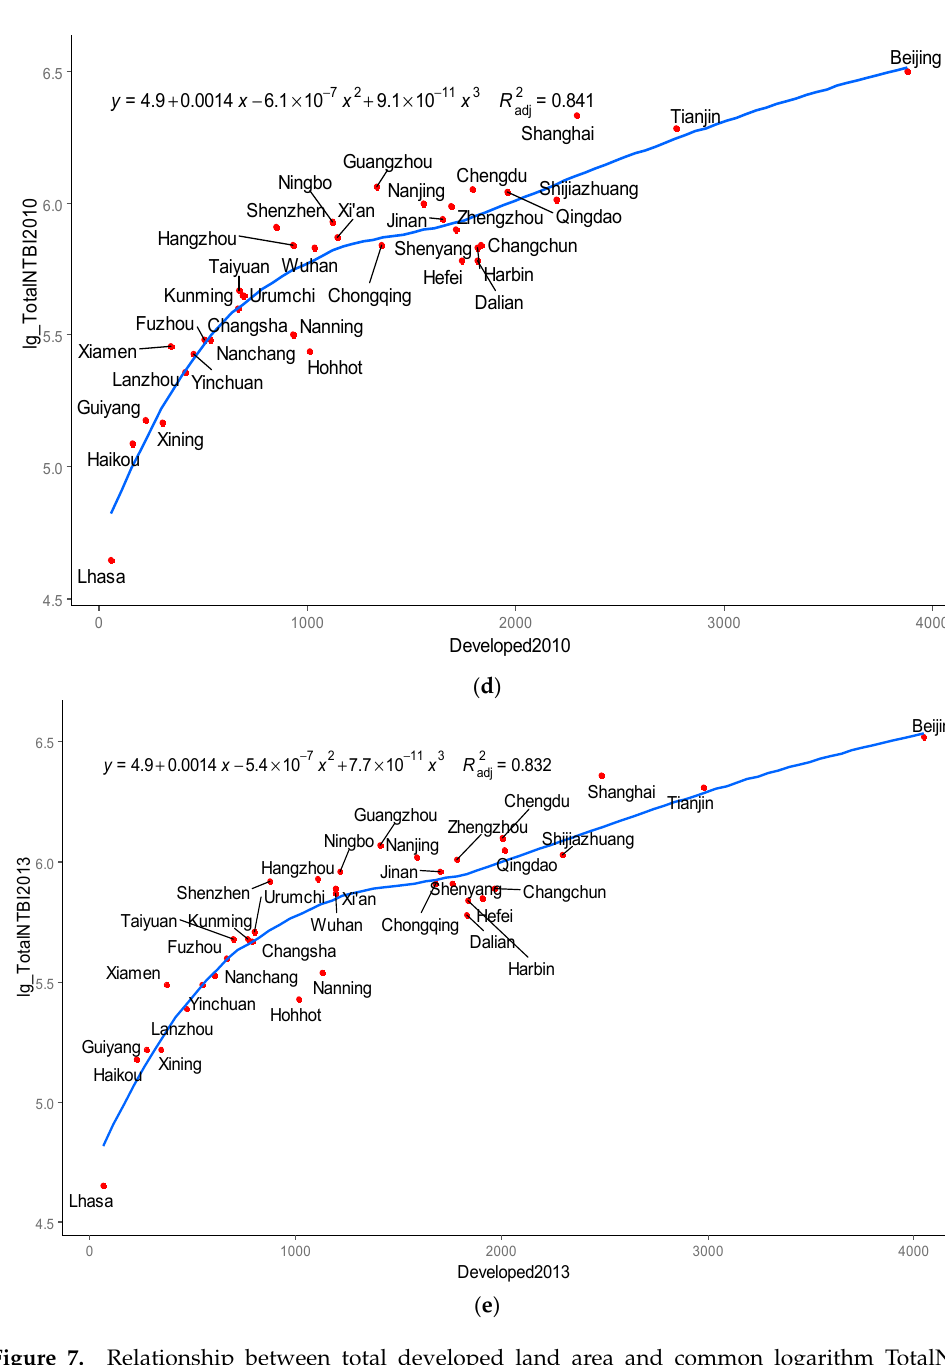
Figure 7. Relationship between total developed land area and common logarithm TotalNTBI (lg_TotalNTBI) in ( a ) 2000, ( b ) 2005, ( c ) 2008, ( d ) 2010, and ( e ) 2013. Total developed land area was in km 2 and lg_TotalNTBI was in cumulative unitless DN value (CUDV). The fitted blue line denotes the trendline.